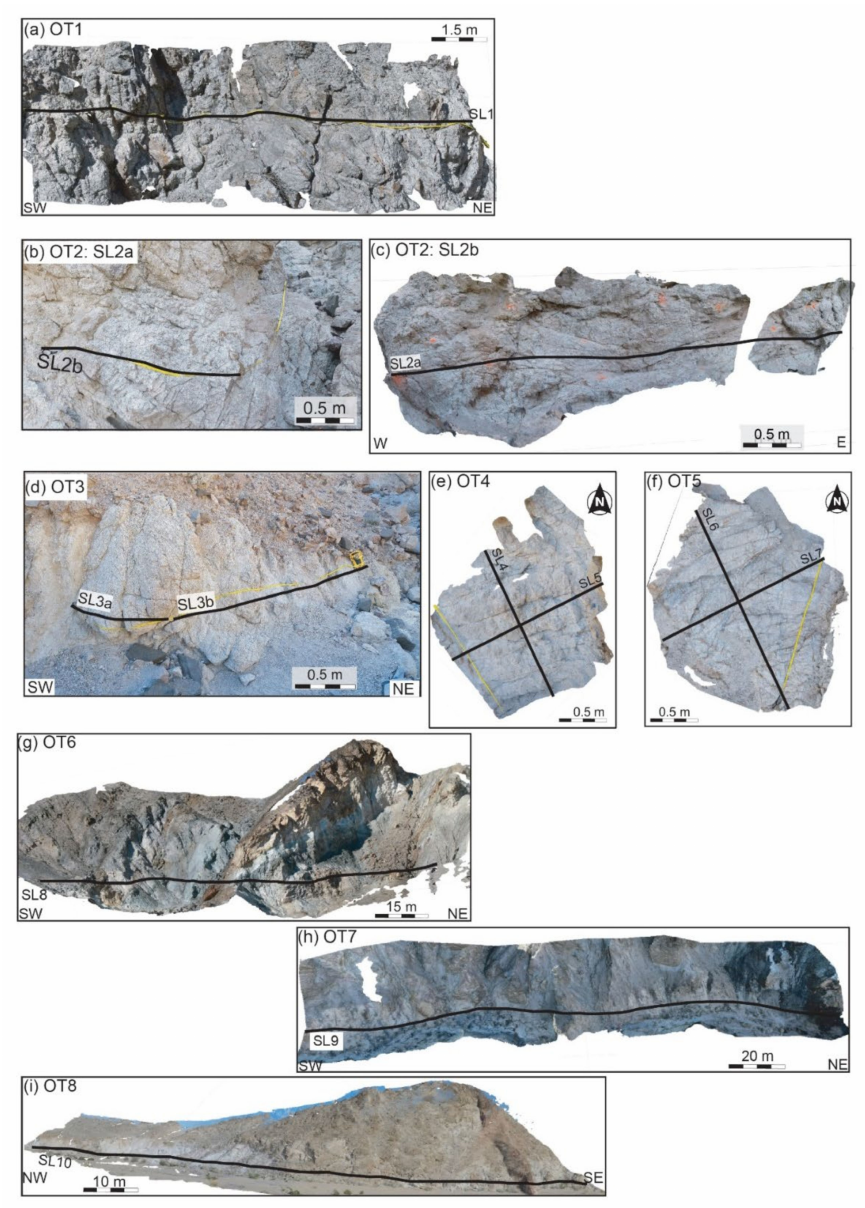
Figure 4. Visualization of the eight outcrops studied in this work, including the scanlines (SL) location. ( a ) Outcrop 1 trending SW/NE shows heterogeneity of fracture orientation distribution. ( b , c ) Outcrop 2 trending E/W shows large NE/SW and NW/SE fracture planes crosscut by SL2a and SL2b. ( d ) Outcrop 3 trending NW/SE shows large E/W fracture planes crosscutting SL3a and SL3b. ( e ) Outcrop 4 consists in a fracture map; 2 scanlines were traced perpendicular to the main structures, recording then large E/W and N/S fracture planes for SL4 and SL5 respectively. ( f ) Outcrop 5 also consists in a fracture map; 2 scanlines were traced perpendicular to the main structures, crosscutting mainly fracture planes orientated NW/SE for SL6 and E/W for SL7. ( g ) Outcrop 6 consists in a canyon perpendicular to the SDVFZ segments, which crosscuts a large E/W fracture plane. This outcrop shows the transition between granitic basement and Crystal Spring sedimentary rocks. ( h ) Outcrop 7 trending NE/SW records a several fracture plane orientations. ( i ) Outcrop 8 trending NW/SE highlights mainly NE/SW and E/W fracture planes. SDVFZ: Southern Death Valley Fault Zone. For outcrops location, see Figure 2. Note that the OT6, 7 and 8 cross some major talus slopes. These outcrops have been modeled in 3D, making the fracture digitation possible to do in CloudCompare software. Then, the planes have been projected in 2D to keep data homogeneous from all fracture